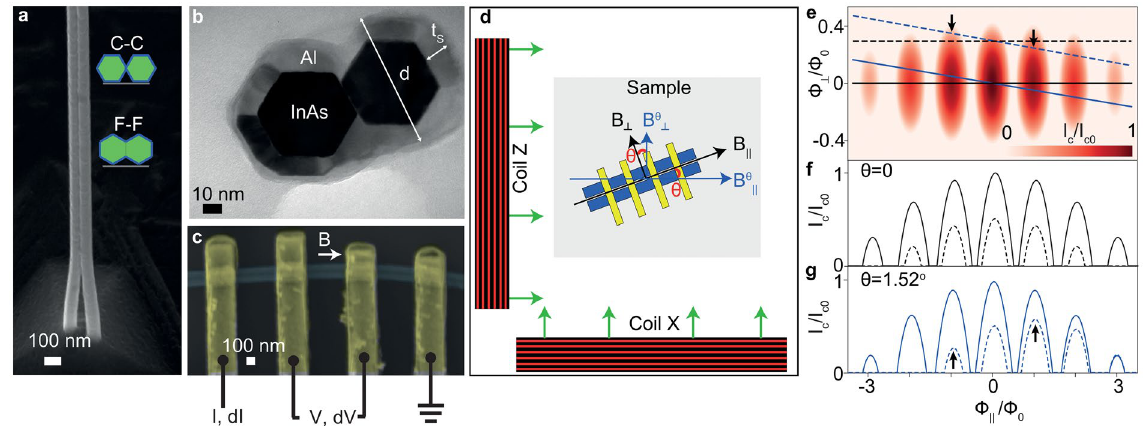
Figure 1. Experimental setup and model for asymmetric Little–Parks effect. ( a ) Scanning electron micrograph of as-grown InAs double nanowire covered with in-situ deposited epitaxial Al. The inset shows two possible relative configurations of the six-faceted nanowires. ( b ) Transmission electron micrograph of a ≈ 80 nm-thick slice of double nanowires. ( c ) False-colored scanning electron micrograph of a device. ( d ) Schematics of the magnetic field setup. ( e – g ) I c dependence on parallel and perpendicular magnetic fluxes calculated with a